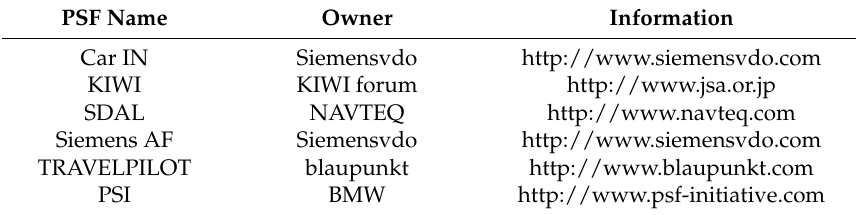
Table 1. Major Physical Storage Format (PSF) used for Vehicle Navigation